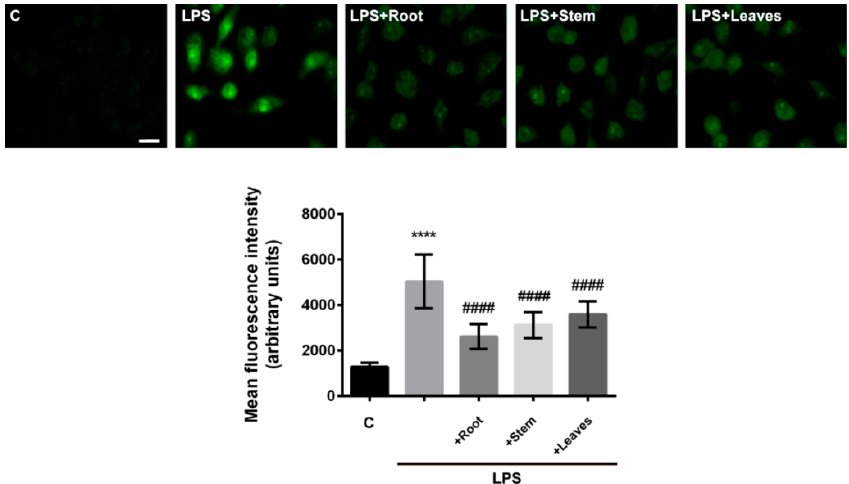
Figure 3. E ff ects of G. tridentata extracts on the LPS-triggered production of ROS by macrophages. Cells were cultured in the indicated conditions and the ROS production was assessed with H 2 DCFDA (green), a ROS-sensitive fluorescent probe. Hoechst (blue) was used to label the nuclei. Images representative of di ff erent fields were acquired at a magnification of 63 × (scale bar = 20 µ m). Data is presented as mean fluorescence intensity ± SD from three independent experiments. (**** p < 0.0001: C vs. LPS; #### p < 0.0001: LPS vs. extracts + LPS).